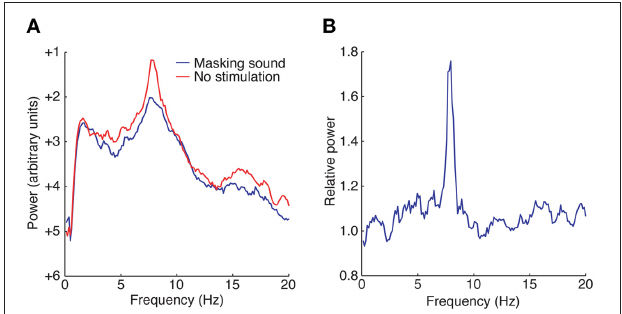
FIGURE 3 | Magnetoencephalograms (MEGs) reveal abnormal rhythmicity in the auditory cortex of tinnitus patients. (A) MEGs of spontaneous neural activity from tinnitus patients show a distinct peak in the theta range ( red ) that is suppressed when a masking sound is presented ( blue ). (B) The relative power of these two conditions reveals a strong coherent theta rhythm under spontaneous conditions. Figure adapted from Llinas et al.